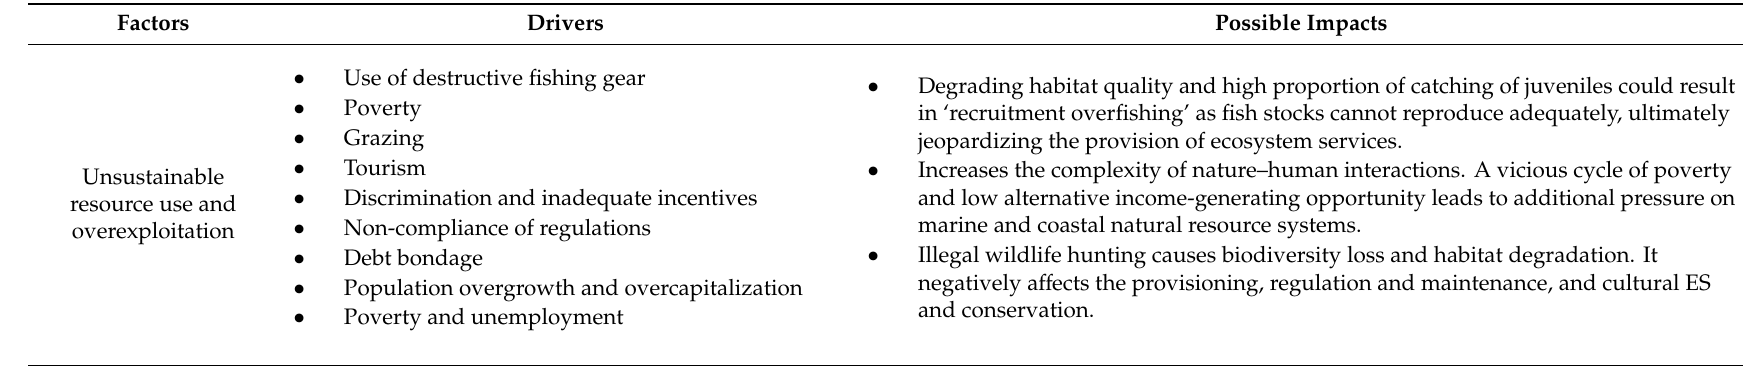
Table 6. Factors or reasons acting as the drivers of ecosystem service changes along Bangladesh’s south-eastern coast (based on respondents’